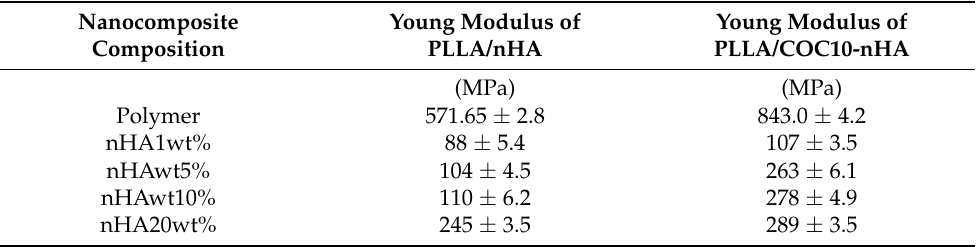
Table 2. Presenting the young modulus of PLLA/COC/10-nHA and PLLA-nHA nanocomposites.